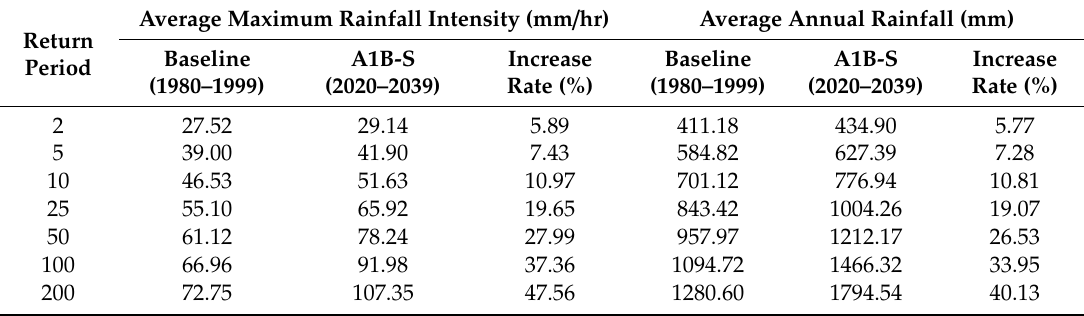
Table 1. Average maximum rainfall intensity and average rainfall increase rates under baseline and A1B-S scenarios for various return